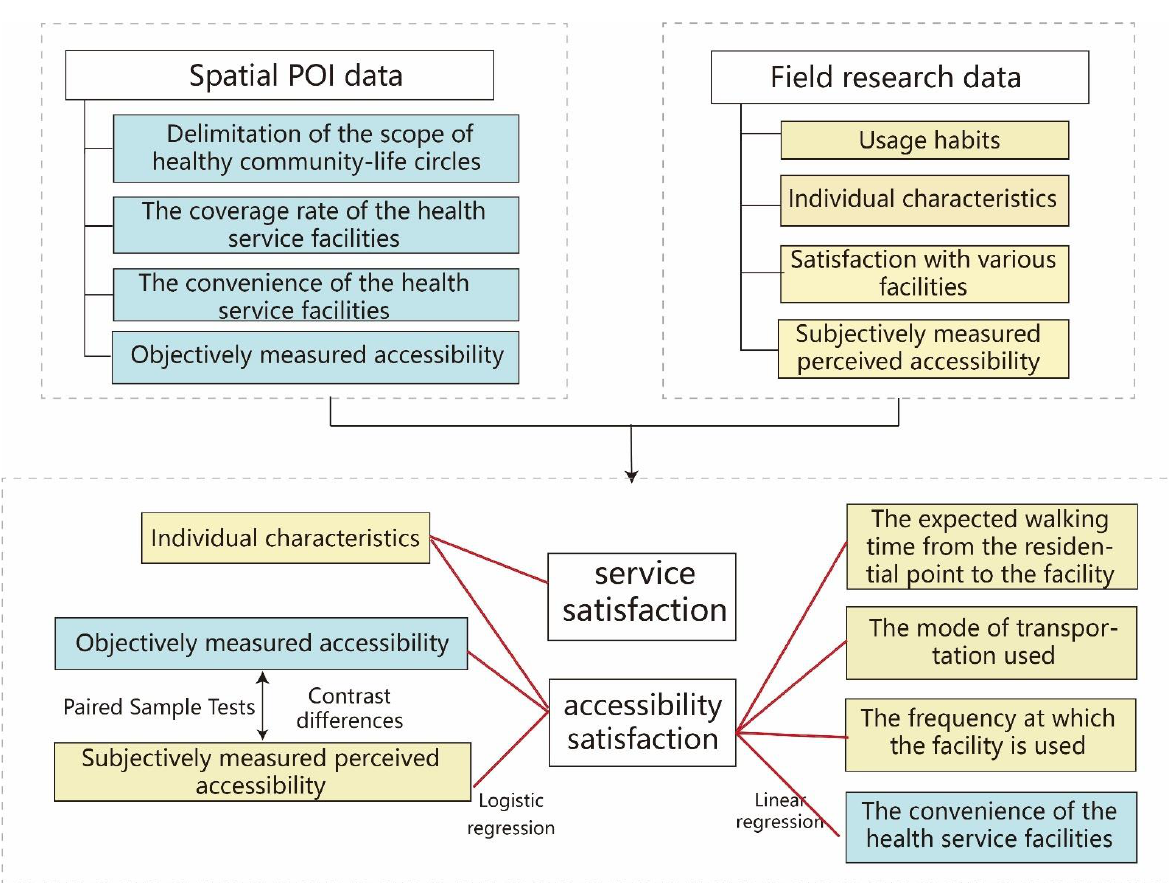
Figure 2. Research